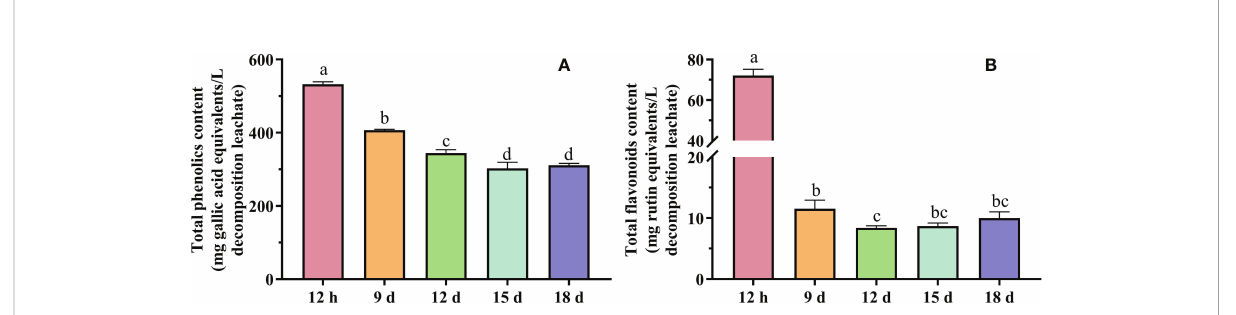
FIGURE 3 Total phenolic (A) and total fl avonoid (B) content of different decay time decomposition leachates. Different letters denoted signi fi cantly different ( P < 0.05) among different decomposition leachates of decay durations. Bars represent three repetitions ± SD.